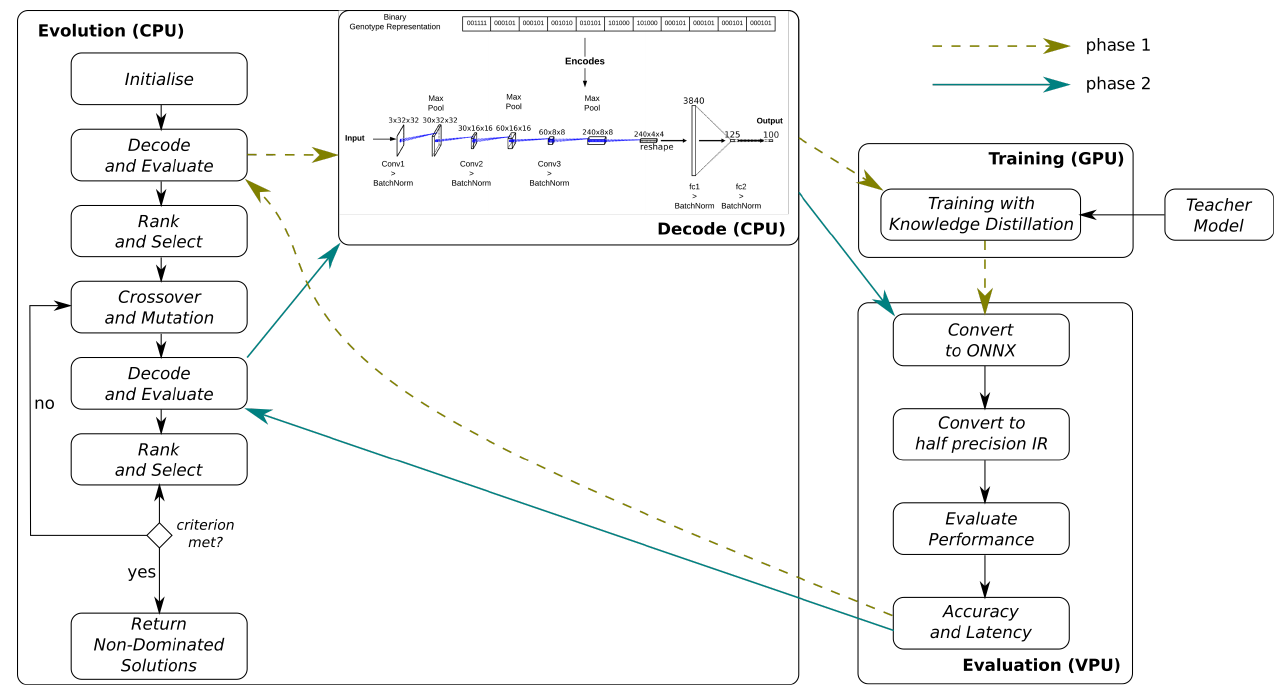
Figure 4. NEMOKD